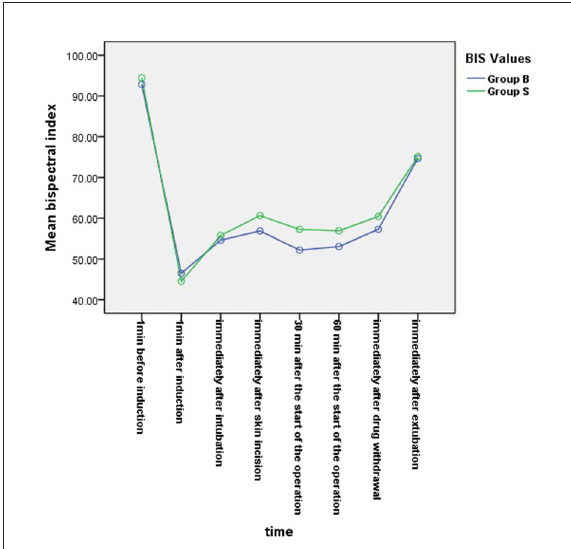
FIGURE2 Changes in bispectral index (BIS) values at each time point in the two groups. BIS values significantly differed among the eight time points as well as between the two groups ( P < 0.05). At the time points 30min after the start of the operation, 60min after the start of operation and immediately after drug withdrawal, the BIS values in group S were significantly higher than those in group B ( P < 0.05).